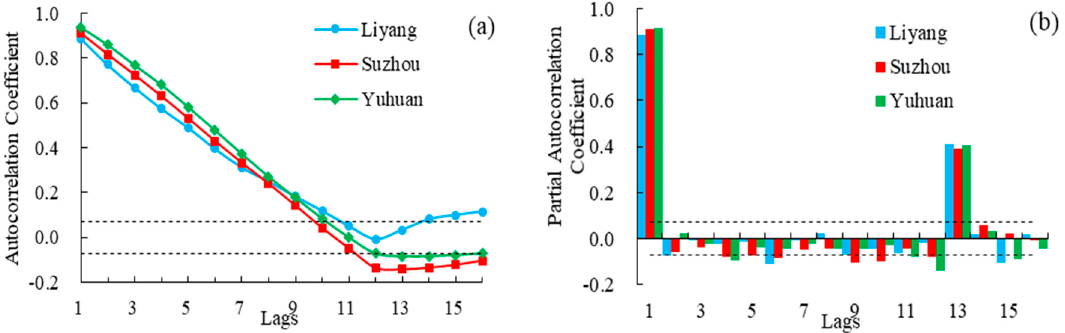
Figure 2. Autocorrelation ( a ) and partial autocorrelation functions ( b ) of SPI-12 at three representative stations.